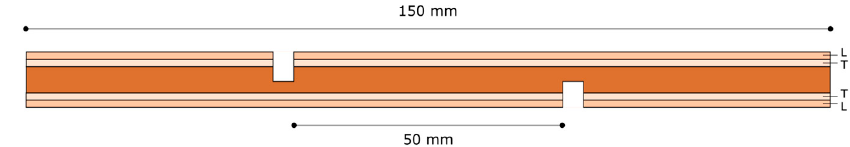
Figure 1. Outline of a specimen subjected to shear test: the cork core is colored dark brown, and the fromager veneers are colored two different, lighter colors according to their wood fiber orientation (L, longitudinal; T, transversal to the specimen major axis).